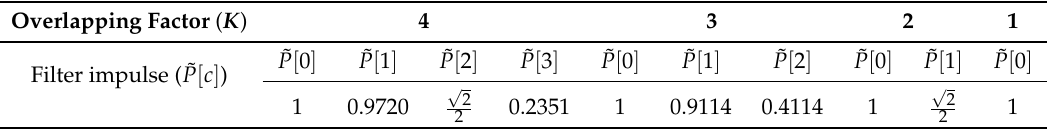
Table 5. Different values of overlapping factors.